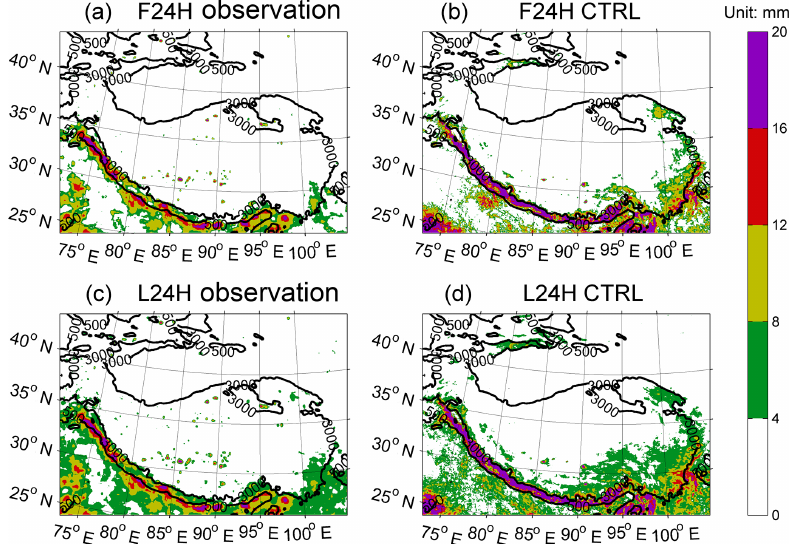
Figure 4. Daily precipitation averaged (unit: mm) for the month of July 2015. (a, b) are F24H forecast, and (c, d) are L24H forecast. Black contours are altitude (unit: m).